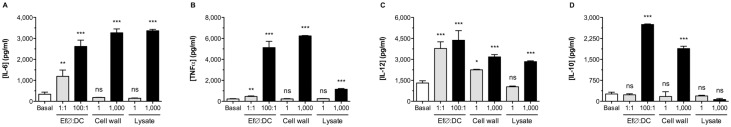
BM-DCs stimulation with E. faecalis CECT7121 cell walls and soluble lysate.BM-DCs were in vitro stimulated with E. faecalis CECT7121 cell walls (μg) and soluble lysate (μg of total protein), and IL-6, TNFα, IL-12, and IL-10 were measured in culture supernatants after 24 h (A, B, C, and D, respectively). Heat-killed E. faecalis CECT7121 (MOIs 1:1 and 100:1) was employed as a positive control. Cytokine levels were expressed as mean pg/mL ± SEM. ns: non-significant, *p<0.05, **p<0.01, ***p<0.001 (One-way ANOVA and Dunnett’s Multiple Comparison tests after ‘sqrt(IL-12)’ or ‘Log(TNFα)’ transformations). E. faecalis CECT7121 cell walls and soluble lysate show different behavior. Both stimuli are able to induce IL-12 and IL-6, but the soluble lysates induce low TNFα and fail to induce IL-10 production.